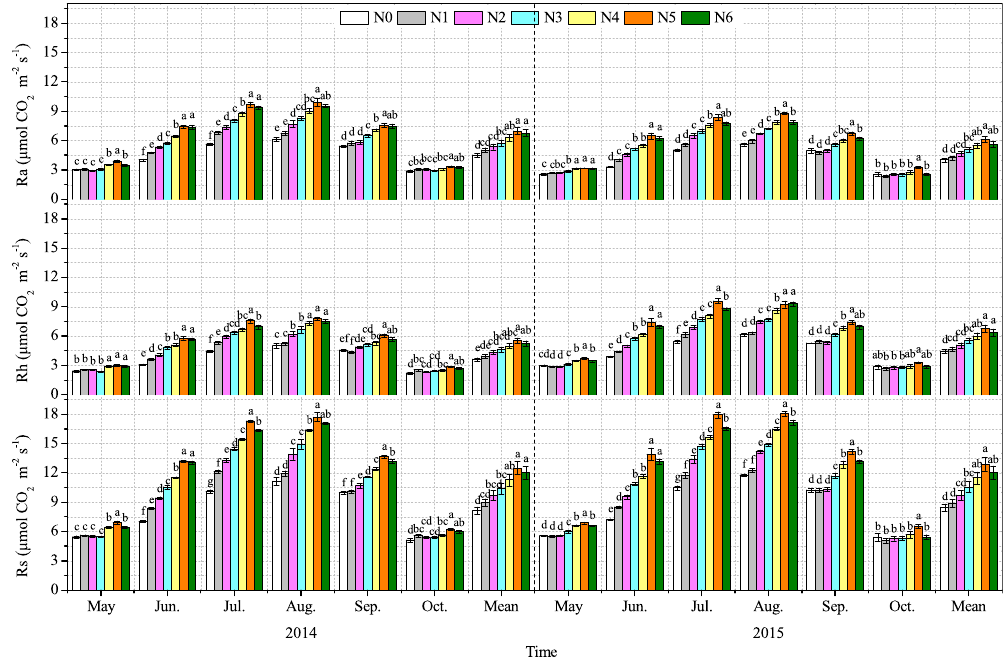
Figure 1. Seasonal variation in autotrophic respiration (Ra), heterotrophic respiration (Rh) and soil respiration (Rs) in an alpine meadow under different nitrogen-addition treatments. N0, N1, N2, N3, N4, N5 and N6 represent 0, 54, 90, 126, 144, 180 and 216 kg N ha − 1 yr − 1 , respectively. Mean: the average value of soil respiration from May to October. Different letters in the same month indicate significant differences at P < 0.05. Twelve replications for Rs, Ra and Rh at each month,